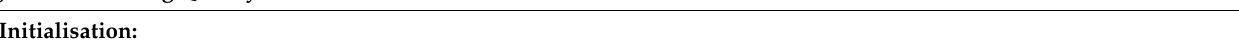
Algorithm 1. Paving Quality Feedback Control